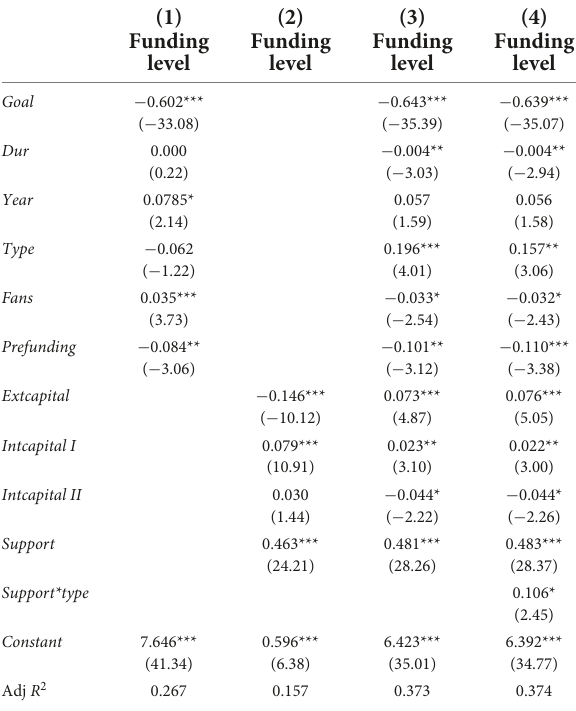
TABLE 4 Robustness